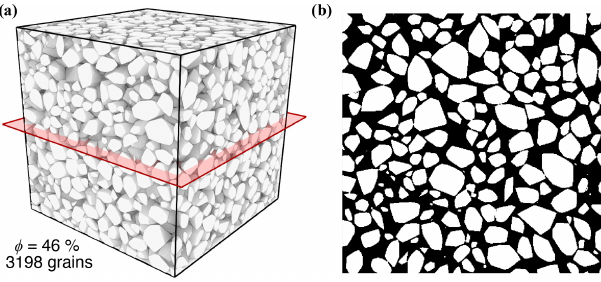
Figure 3. (a) Three dimensional virtual sample of well sorted ce- lestite grains with a mean grain diameter of 42µm is used to deter- mine the inner surface area. (b) Two-dimensional slice through the virtual celestite grain pack (red plane in a